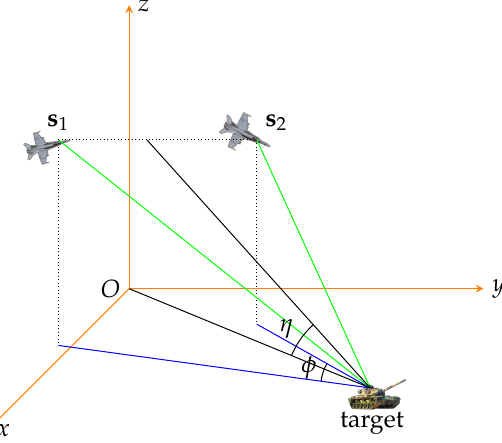
Figure 6. Definition of the intersection angle φ and pitch angle η of the plane.